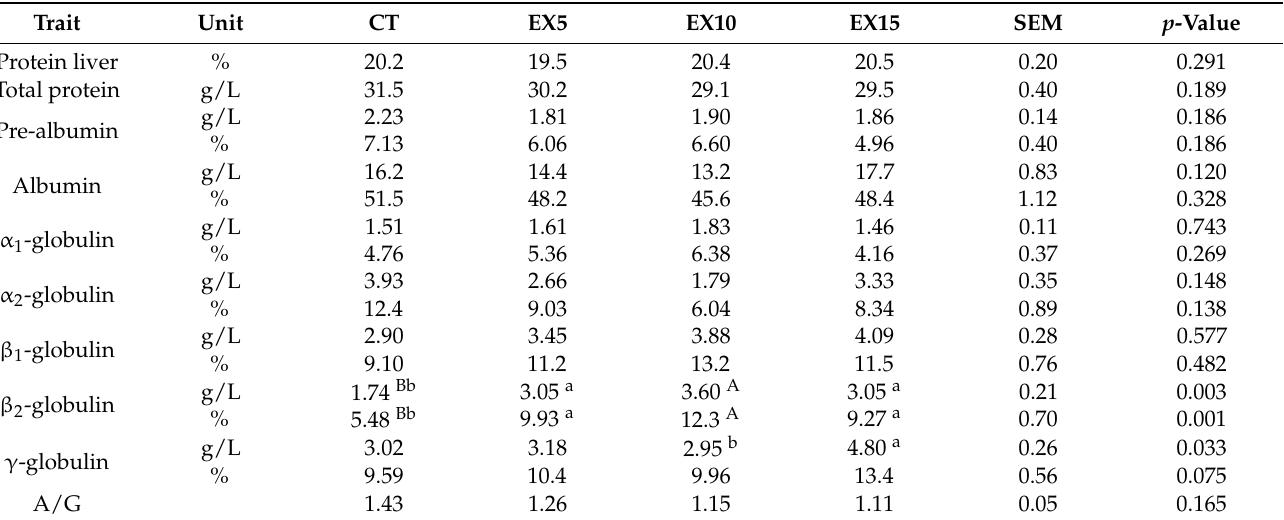
Table 7. Protein content in the liver and total protein and its fractions in the blood serum of male 43-day-old Ross-308 broilers (Mean, SEM, n =